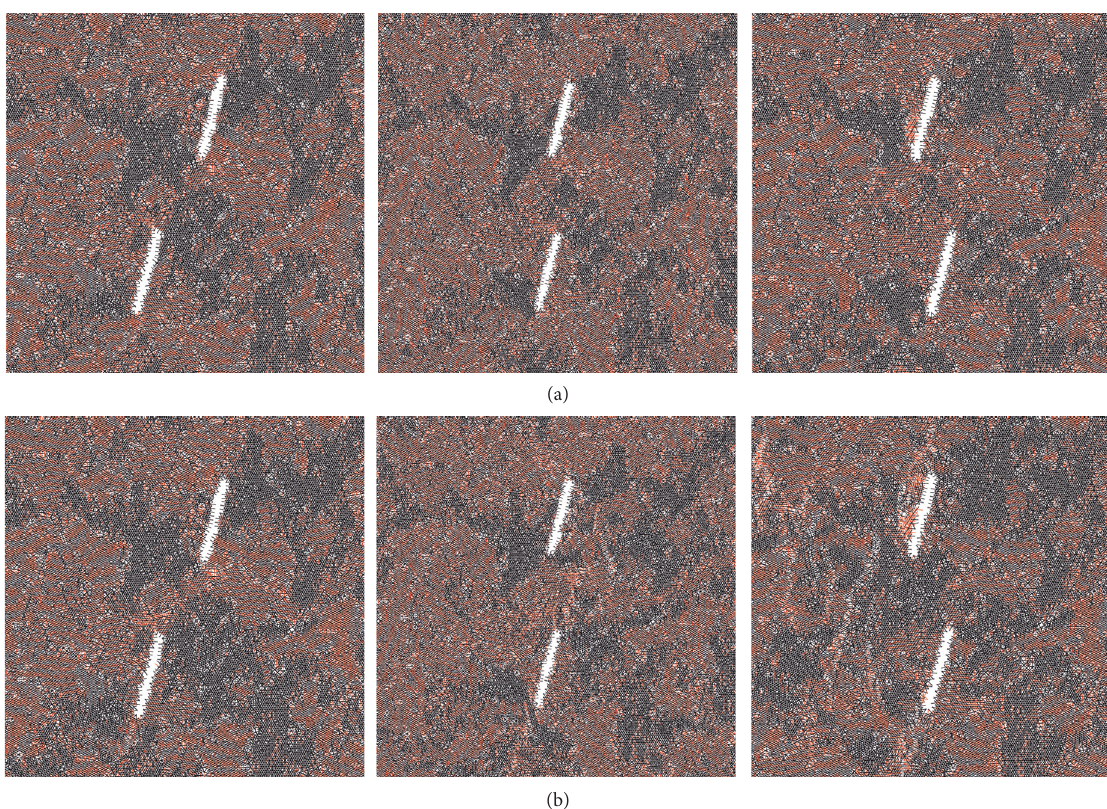
Figure 7: Contact force chain of samples containing unfilled flaws with the same α of 75 ° and different β of 60 ° , 90 ° , and 120 ° at the (a) crack initiation moment and (b) peak stress moment (red contact force chain represents tension and black contact force chain represents